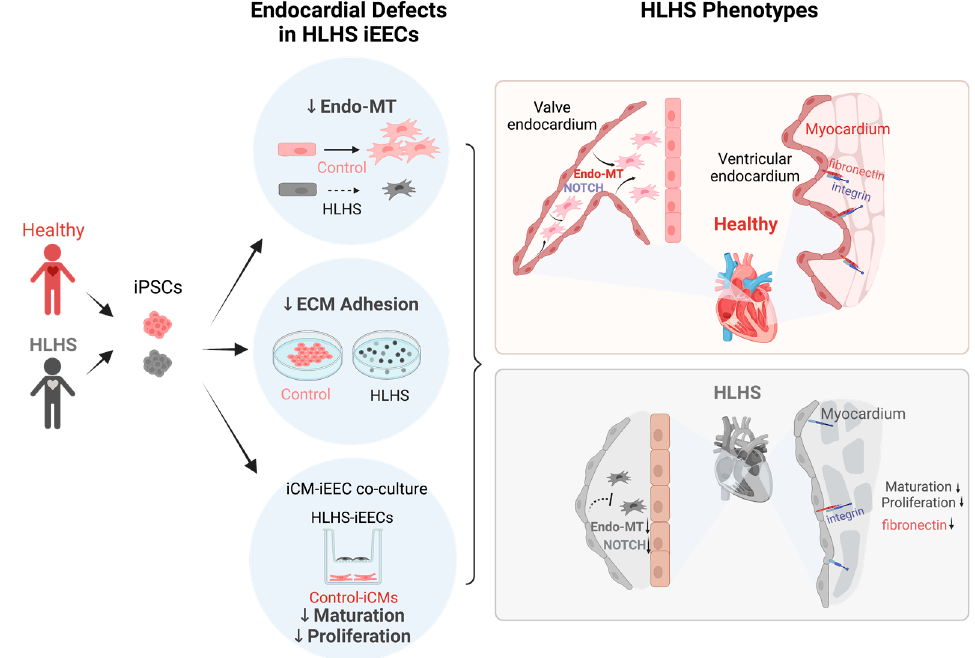
Figure 1. Using iPSC-derived endocardial EC (iEEC) to study the endocardial pathology in HLHS. iPSCs were initially derived from healthy donors and HLHS patients. iEECs were utilized to uncover various EC-related functional defects in HLHS-iEECs, including reduced Endo-MT, ECM adhesion, and the dysregulation of iPSC-derived cardiomyocytes (iCMs). The iEEC-based in vitro studies explained the disease phenotypes of HLHS, such as underdeveloped valve structure and unmatured and low proliferation of cardiomyocytes.